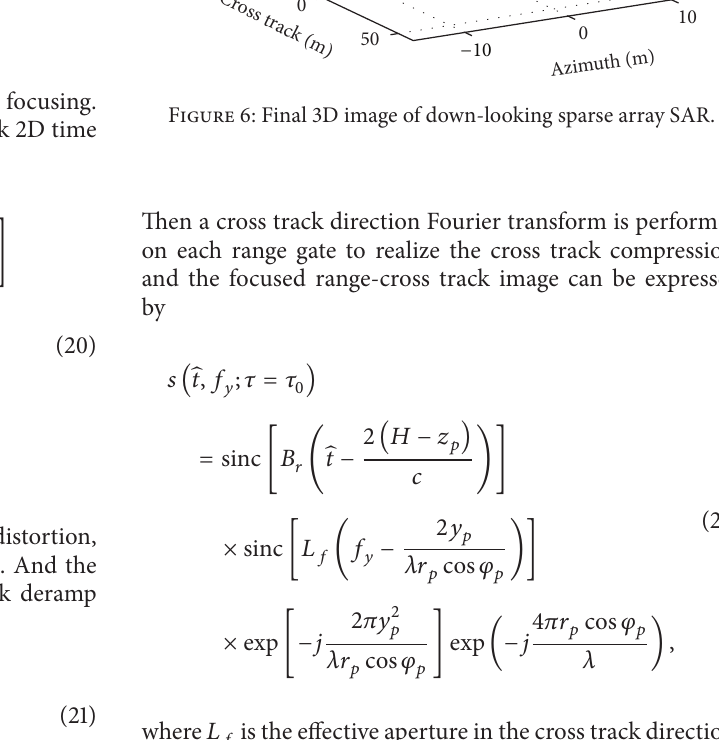
where 𝐿 𝑓 is the effective aperture in the cross track